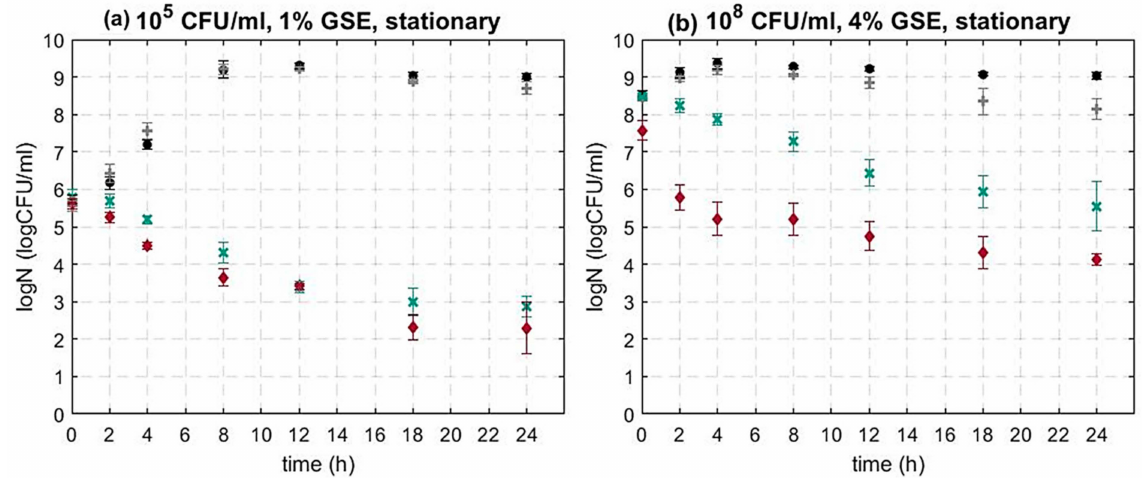
Figure 2. Inactivation dynamics of L. monocytogenes 10403S WT and ∆ sigB at ( a ) initial inoculum concentration 10 5 CFU/mL and 1% GSE ( b ) initial inoculum concentration 10 8 CFU/mL and 4% GSE. In both plots ( • ) control WT ( w/o GSE), ( + ) control ∆ sigB ( w/o GSE), ( × ) treated sample WT with 1% or 4% GSE, ( (cid:7) ) treated sample ∆ sigB with 1% or 4% GSE. Each time point represents the average of two independent experiments with three technical replicates per experiments. Error bars show standard